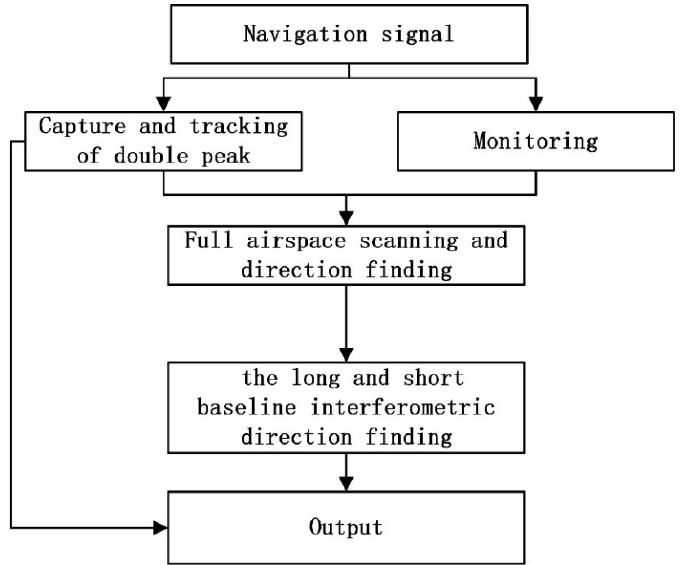
Figure 3. Spoofing interference detection process.